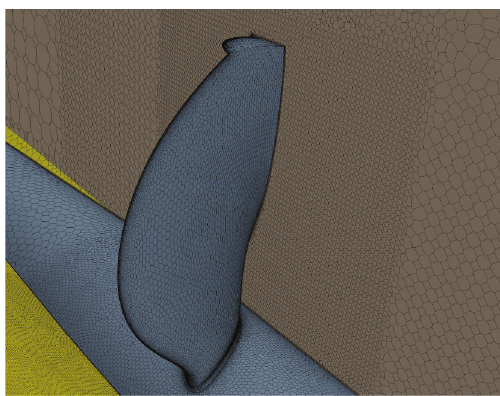
Figure 5: Mesh refinements close to the blade. Finer mesh (1.6 million